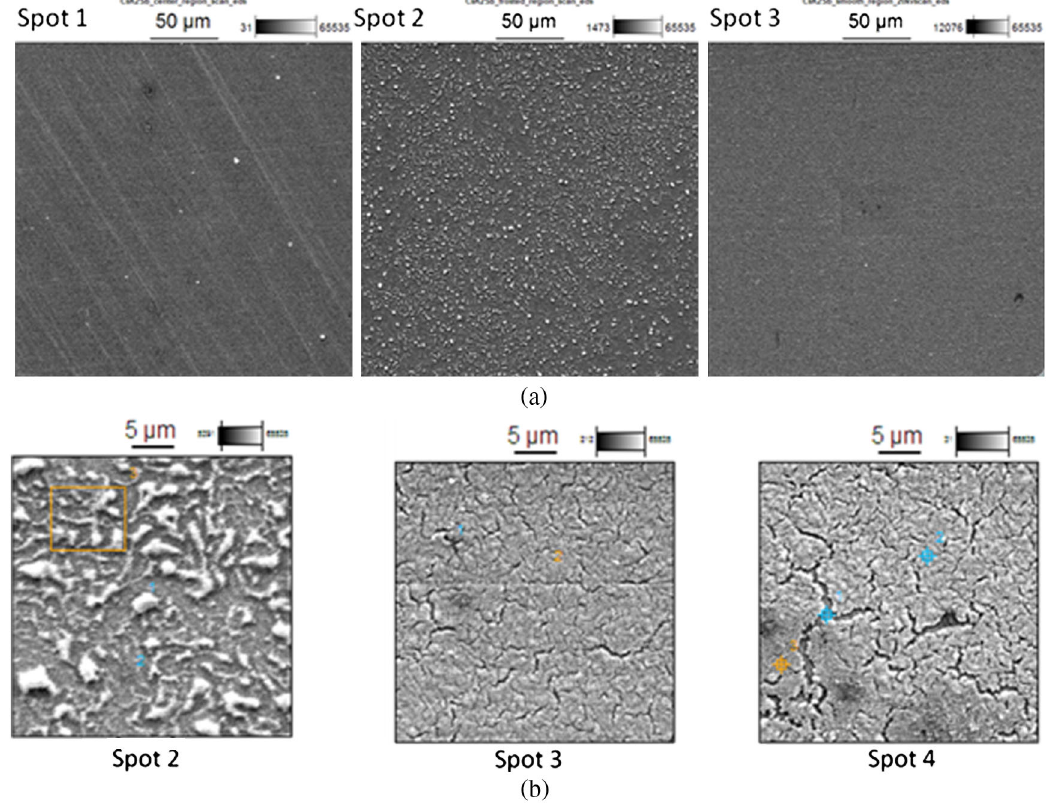
FIG. 17. (a) Surface of photocathode #1 at 400x magnification and (b) 3000x